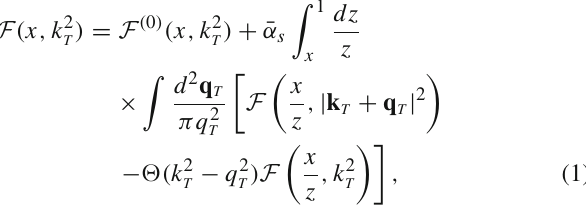
and q T denote the T